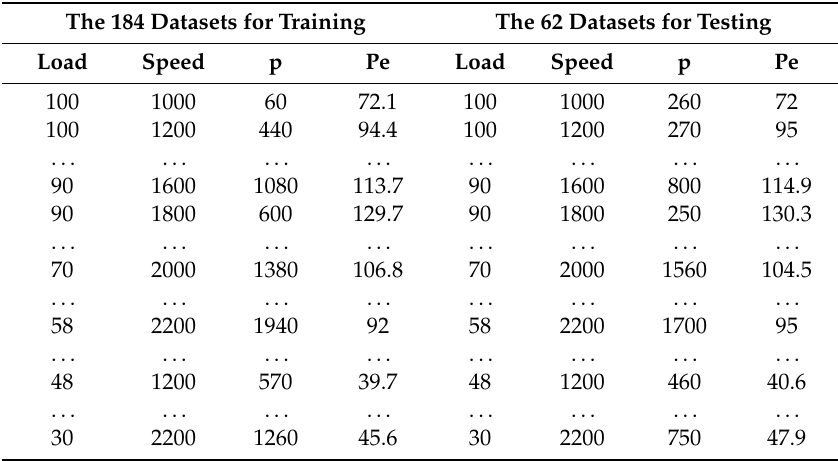
Table A2. Partition of the engine experimental data.